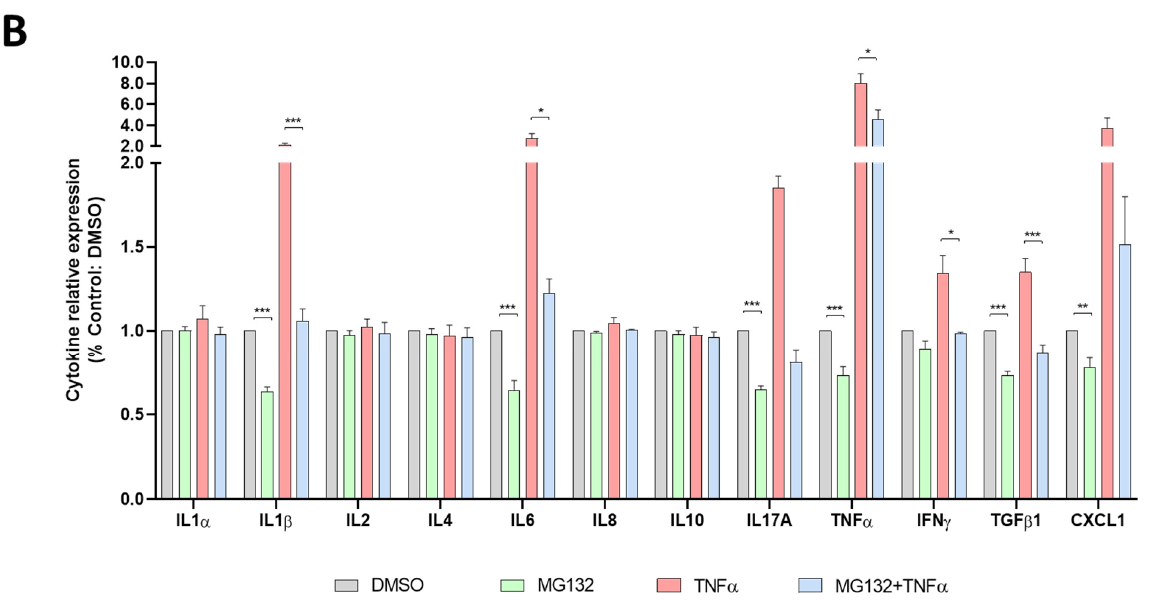
Figure 6. Anti-inflammatory effects of MG132 in HGPS-like and MAD-B cells. ( A ) Quantitative real-time PCR using selected inflammatory genes expression arrays in culture supernatants of HGPS, HGPS-like, and MAD-B fibroblasts treated for 6 h with MG132 (500 nM), TNF α (10 ng/mL) alone and in combination, or DMSO as vehicle control. The results of individual samples (Figure S5) were grouped into biological replicates (1 HGPS, 6 HGPS-like, and 1 MAD-B) to perform statistical tests. (mean ± SEM, n = 8, Student’s t -test, * p < 0.05, *** p < 0.001; MG132-treated vs. DMSO-treated cells and MG132+TNF α -treated vs. MG132-treated cells). ( B ) Enzyme-linked immunosorbent assay (ELISA) using multi-analyte ELISA arrays to measure inflammatory cytokines in culture supernatants from HGPS, HGPS-like, and MAD-B fibroblasts treated for 24 h with MG132 (500 nM), TNF α (10 ng/mL) alone and in combination, or DMSO as vehicle control. The results of individual samples (Figure S6) were grouped into biological replicates (1 HGPS, 6 HGPS-like, and 1 MAD-B) to perform statistical tests. (mean ± SEM, n = 8, Student’s t -test, * p < 0.05, ** p < 0.01, *** p < 0.001; MG132-treated vs. DMSO-treated cells and MG132+TNF α -treated vs. MG132-treated cells).